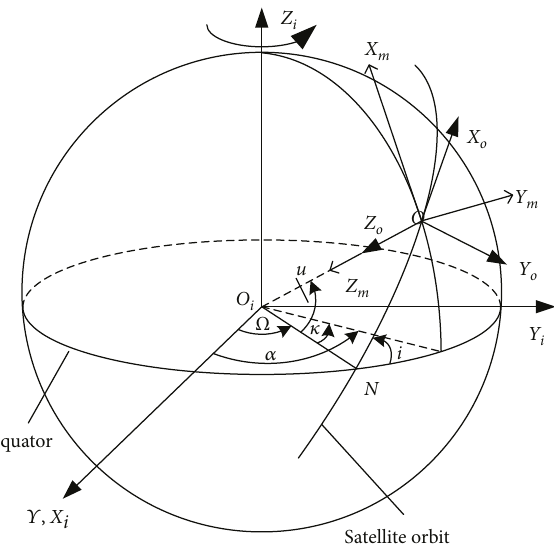
Figure 2: De fi nitions of coordinate systems.